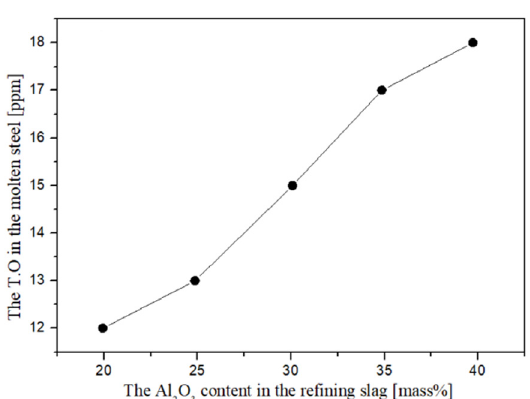
Figure 7. Proportion of inclusions of different sizes in ULC automotive steel.